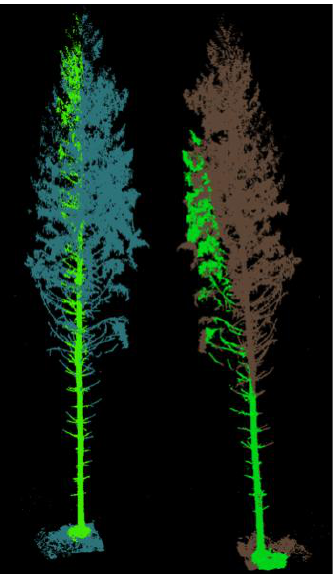
Fig 4. RANSAC cylinder fitting (green) with radius tolerance 1m (left) and 2m (right)